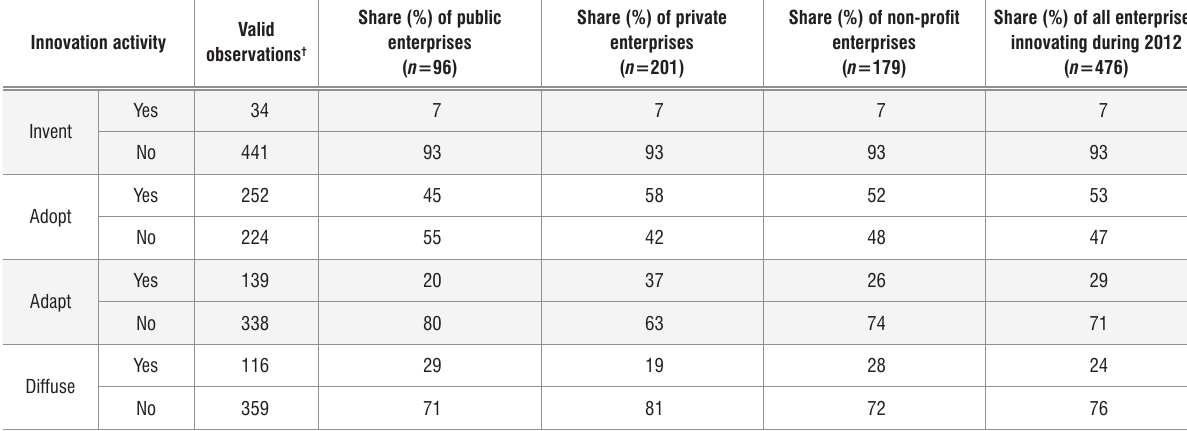
Innovation activity